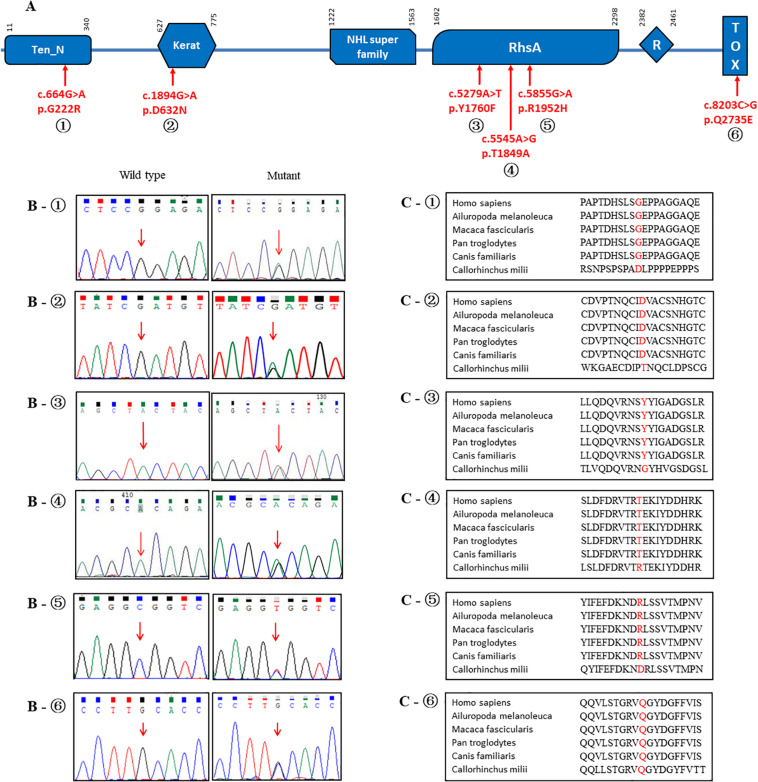
Schematic representations of the TENM4 protein with blue boxes indicating different domains. (A) Variants found in present study are indicated by arrows. (B) Electropherograms of the sequence of the variants. (C) The position and surroundings of those variants are highly conserved across different species.